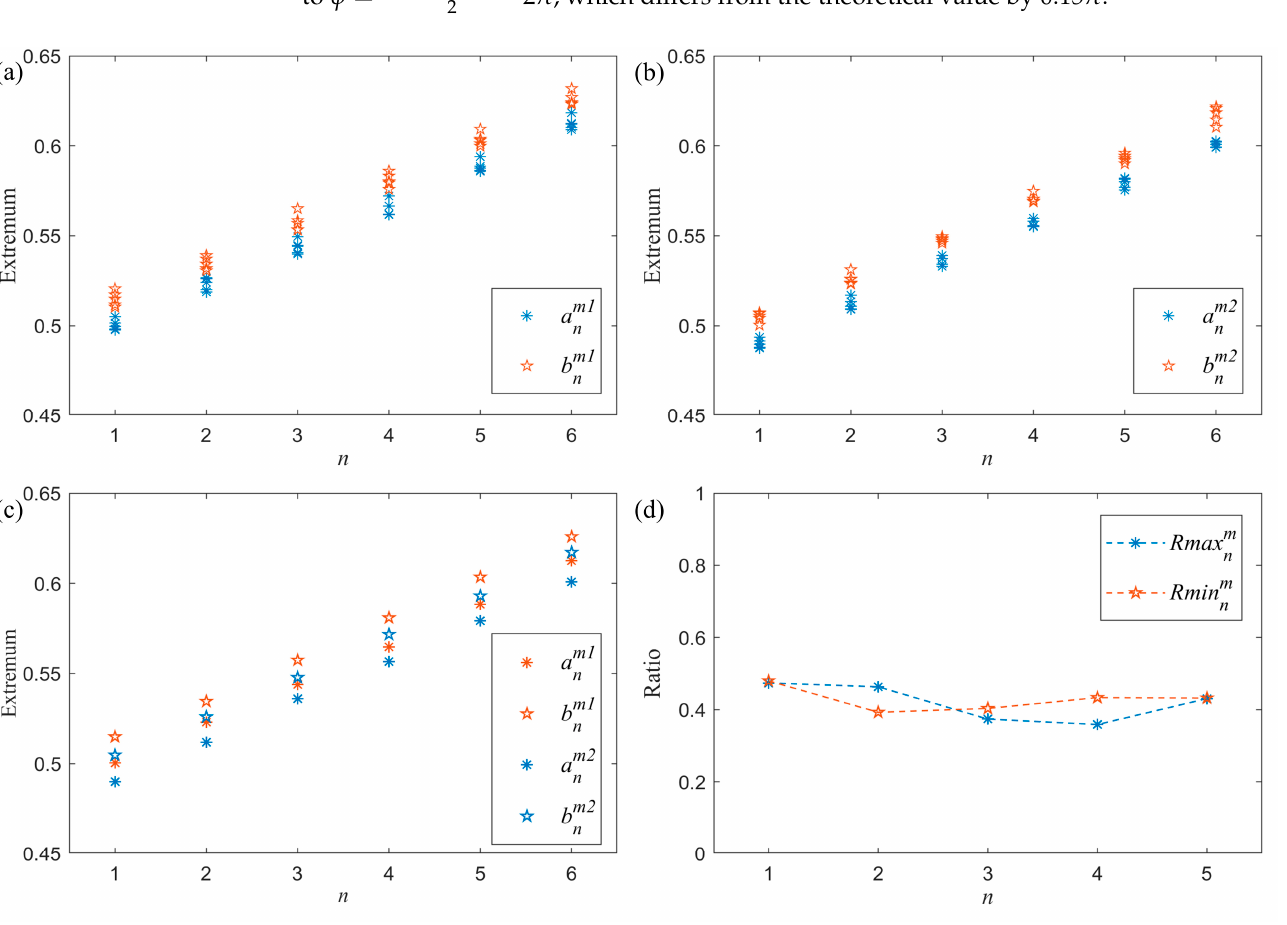
Figure 12. Measurement results of amplitude-division interference experiments at low signal-to-noise ratios. ( a ) extrema of the normalized interference term I ∆ of the coupler output 1; ( b ) extrema of the normalized interference term I ∆ of the coupler output 2; ( c ) average of the corresponding extrema of the normalized interference terms I ∆ of the two outputs; ( d ) Rmax m n and Rmin m n calculated from the extrema.